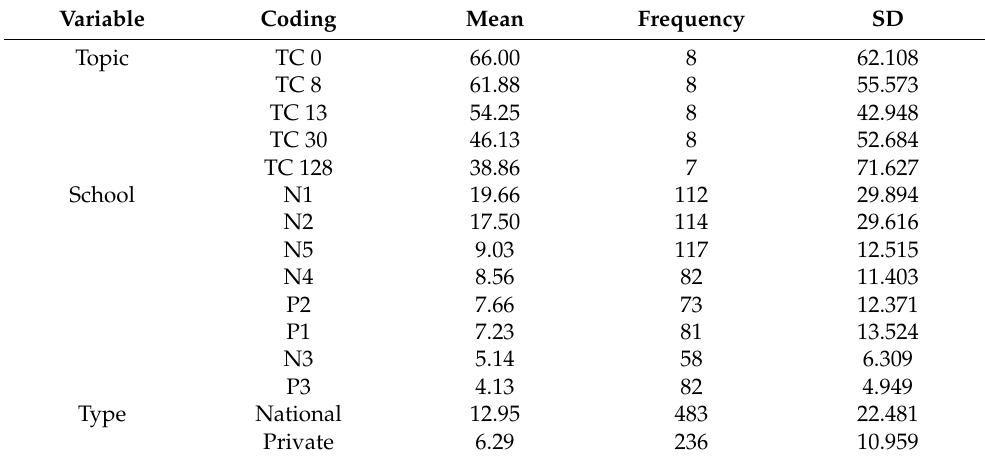
Table 5. Basic statistical analysis (output